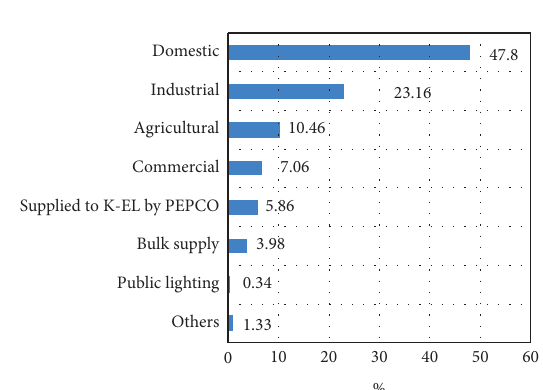
Figure 5: Electric power consumption in different sectors in Pakistan from 2017 to 2018